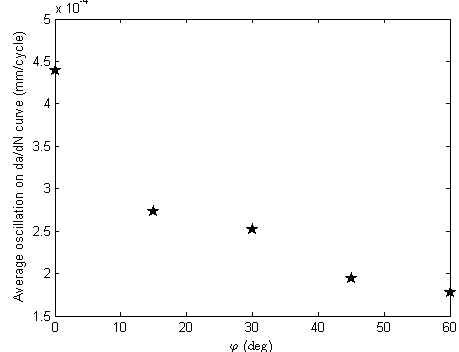
Figure 9: Average oscillation on da/dN curve for the five different angles, φ ,